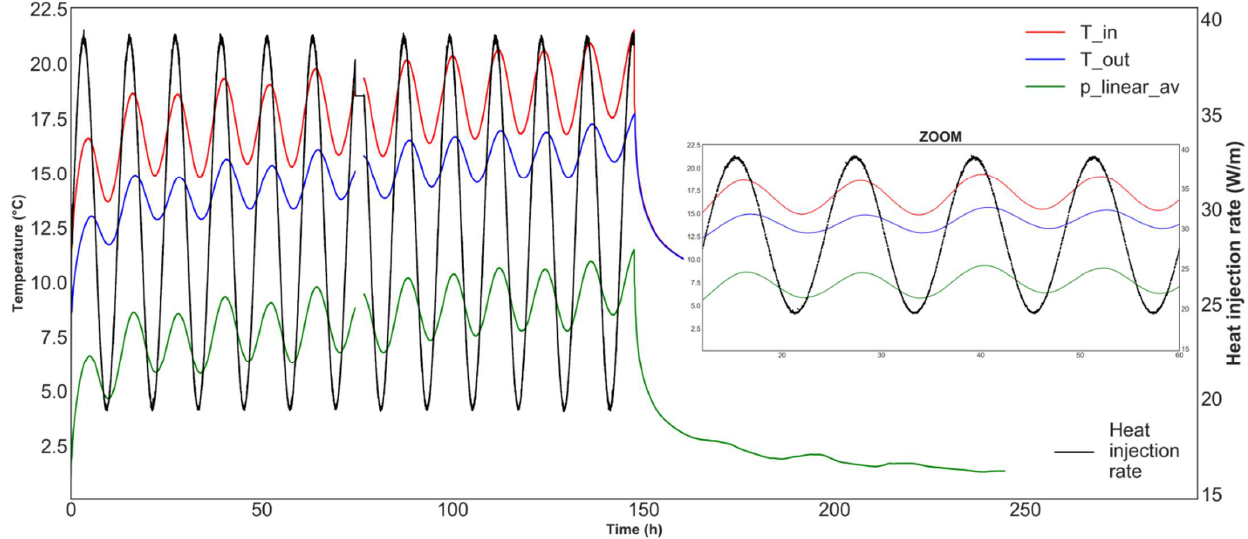
Figure 9. Observed temperature during the OTRT carried out in the field. Inlet (red) and outlet (blue) temperature curves are in absolute values. p -linear average (green) curves show increments with respect to the initial temperature. The p -linear average method (with p = − 1) proposed by [40] was used to calculate the average BHE temperature in order to better represent the temperature profile along the BHE. p values of − 2 (harmonic mean), − 0.5 (geometric mean) and 1 (arithmetic mean) were also considered to evaluate its impact on the analysis of an OTRT. Maximum deviations